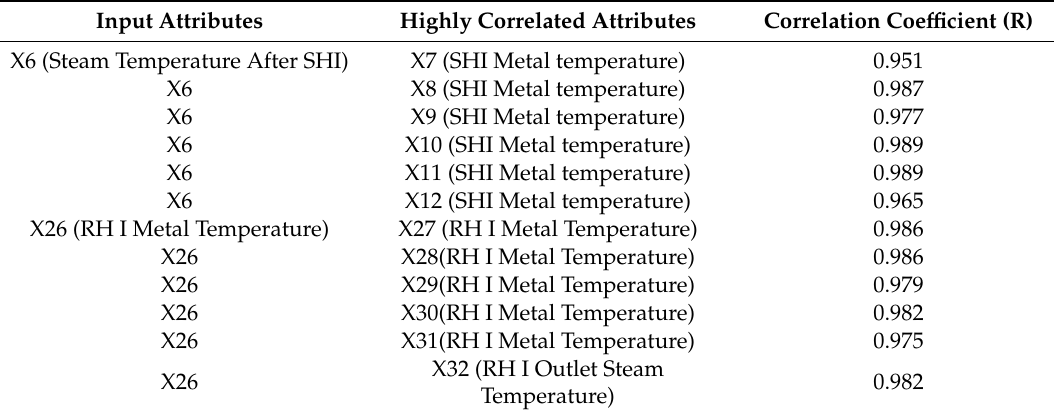
Table 2. Correlation coe ffi cients of highly correlated sensors.